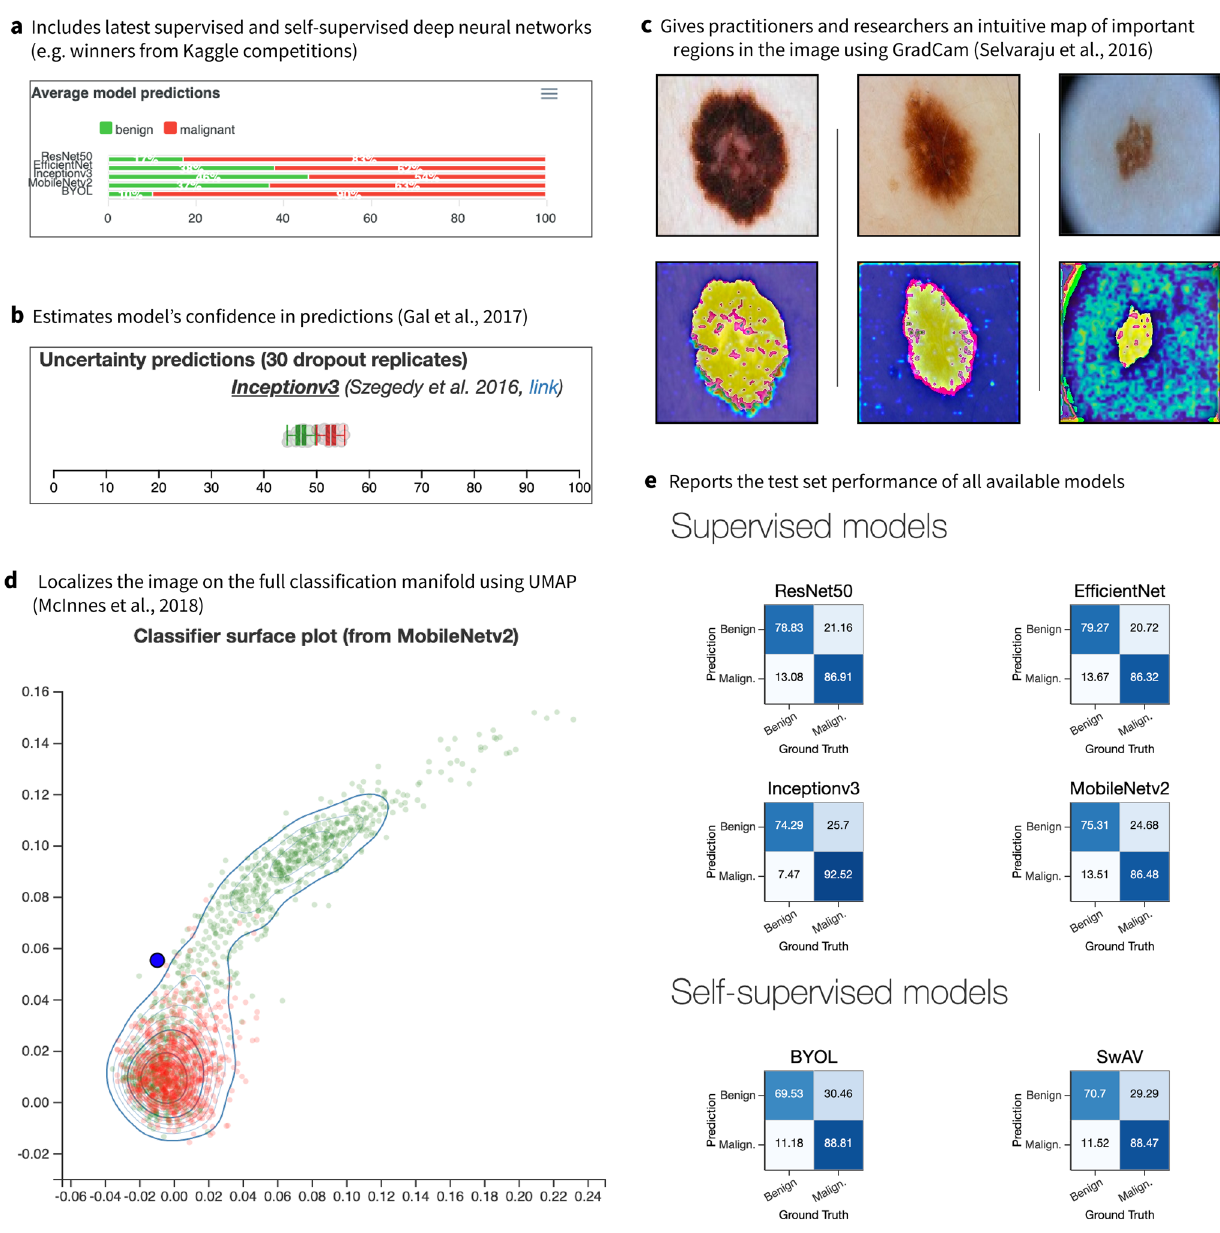
Figure 1. Screenshots of the main features of our DUNEScan web server. ( a ) Average model predictions for a given skin lesion image (malignant or benign) provided by the six available CNN models, ( b ) boxplots showing uncertainty of model predictions, ( c ) Grad-CAM gradient saliency plot of most important lesion features, ( d ) classification manifold from the MobileNetv2 features, ( e ) confusion matrices computed over the test set for all six CNN